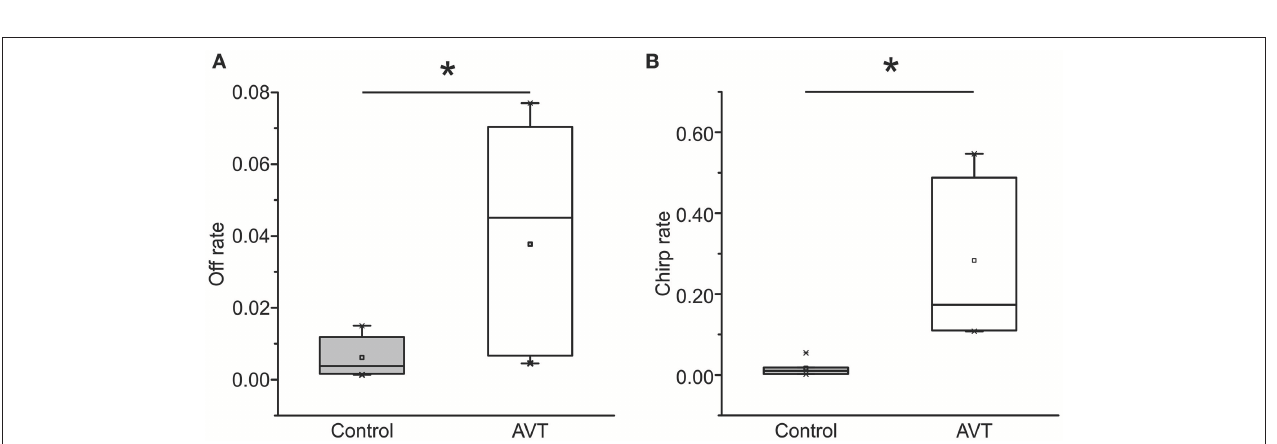
FIGURE 2 | AVT effects on EOD rate change index. (A) Dominants. Neither AVT nor MC treatment affect the EOD rate change index in dominants. Kruskal–Wallis test, p = 0.46. ncontrol = 11, nAVT = 11, nMC = 6. (B) Subordinates. The EOD rate change index of subordinates after AVT treatment is more pronounced with respect to both saline subordinate controls and MC-treated subordinates. Kruskal–Wallis test, p = 0.04. Post-hoc Dunn test, Control vs. AVT, p = 0.04; Control vs. MC, p = 0.32; AVT vs. MC, p > 0.99. ncontrol = 11, nAVT = 9, nMC = 6. Dotted line indicates no change in EOD rate. Lowercase letters show statistically significance: same letter means non significant differences; different letters mean significant differences.